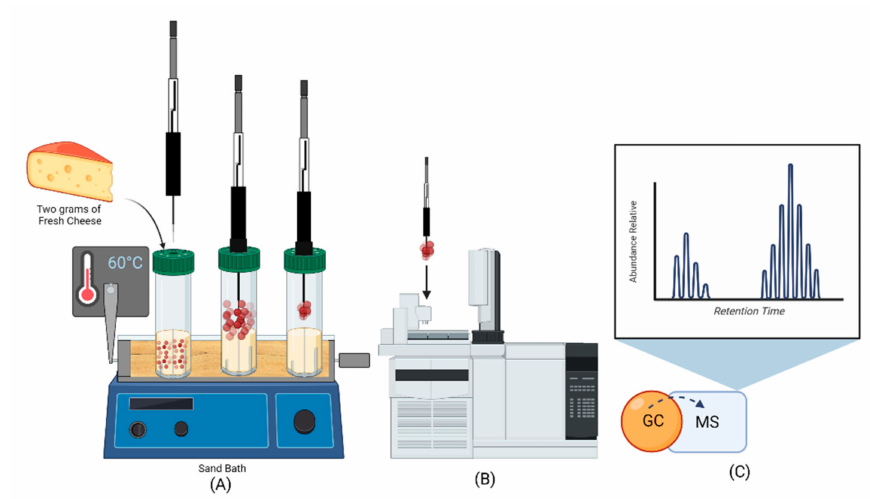
Figure 2. HS-SPME/GC-MS F-MC sampling procedure scheme. ( A ) External view for the steps of the extraction procedure, where the fiber is exposed to the VOCs. ( B ) SPME extraction and thermal desorption in GC injector. ( C ) Analysis and identification of the